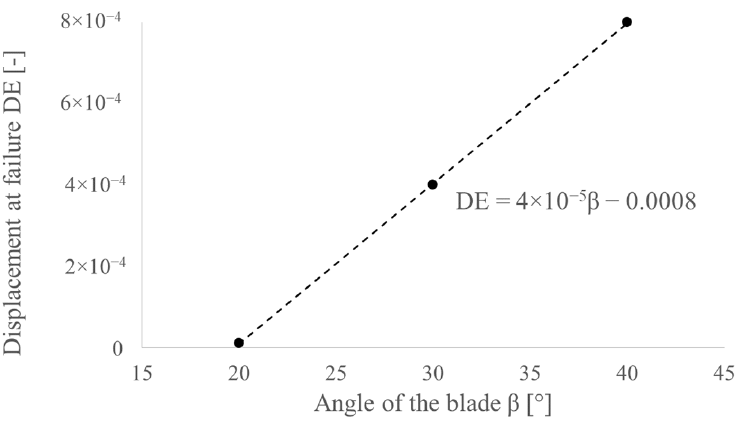
Figure 17. Determination of the damage evolution parameter DE (displacement at failure) for PO punches.